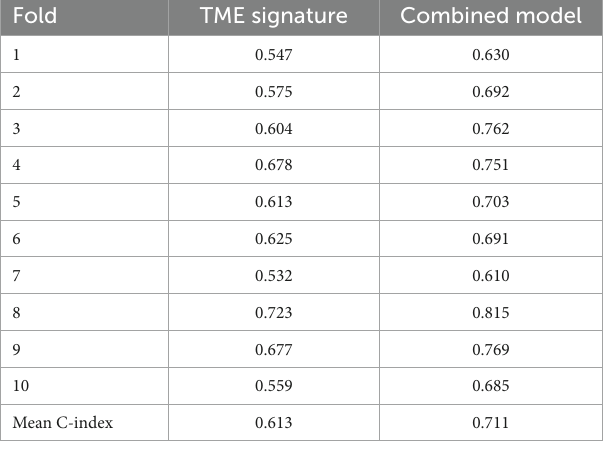
TABLE 5 C-index of TME signature and the combined model in 10-fold cross-validation.